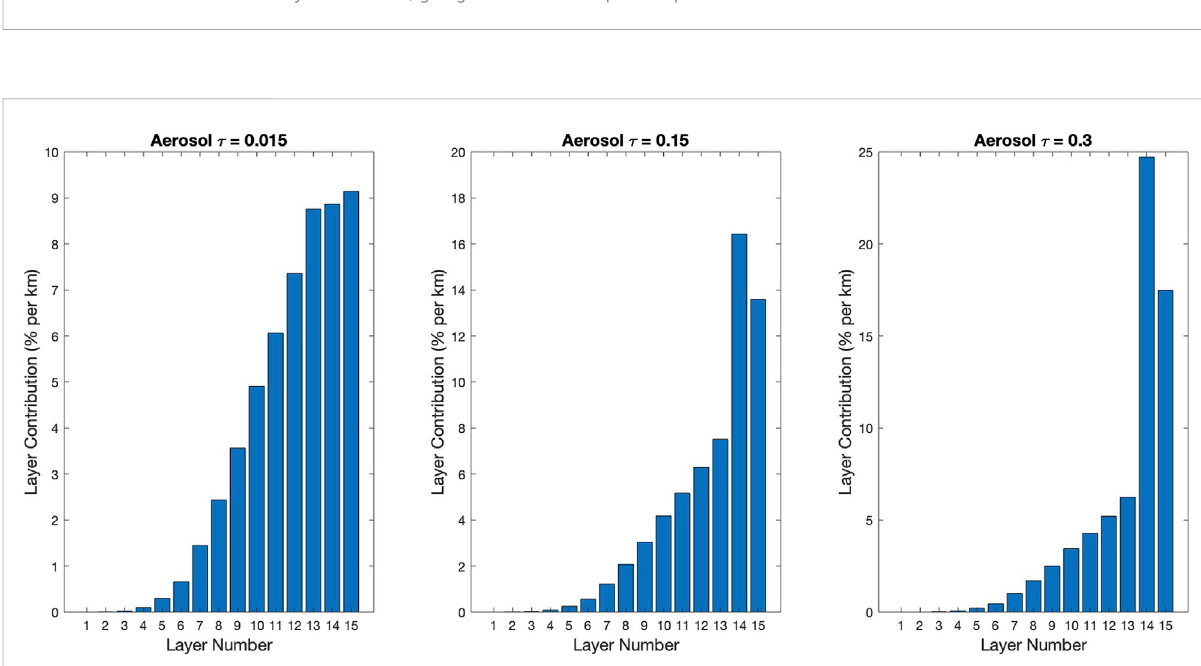
FIGURE 3 Same as Figure 1 except that cloud droplets were mixed with the molecules in layers 14 and 15. The optical depth of the cloud droplets was assumed to be 2.25 in each of layers 14 and 15, giving the total cloud optical depth was 4.5.